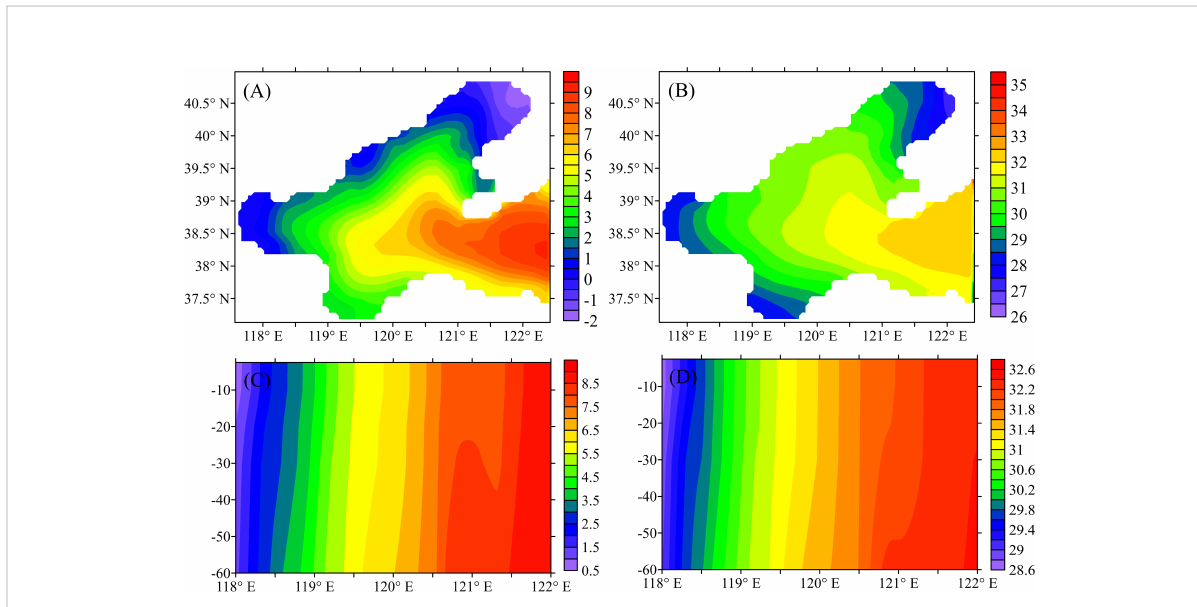
FIGURE 1 Simulated temperature (°C ) (A – C) and salt (B – D) horizontal (A, B) and 38.5 o N vertical (C, D) pro fi le in